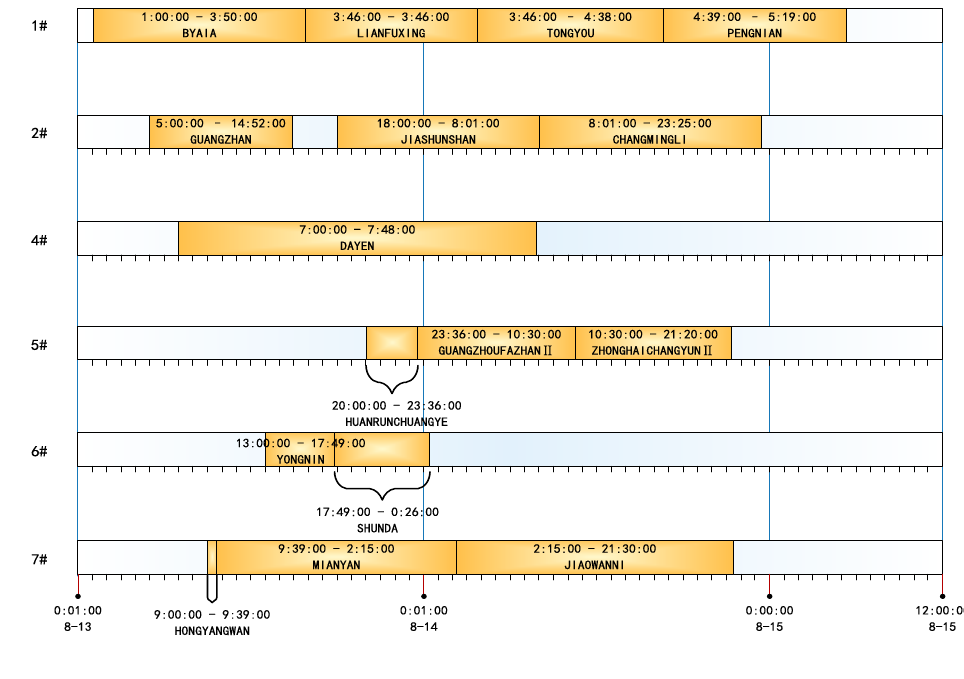
Figure 3. Gantt Chart of